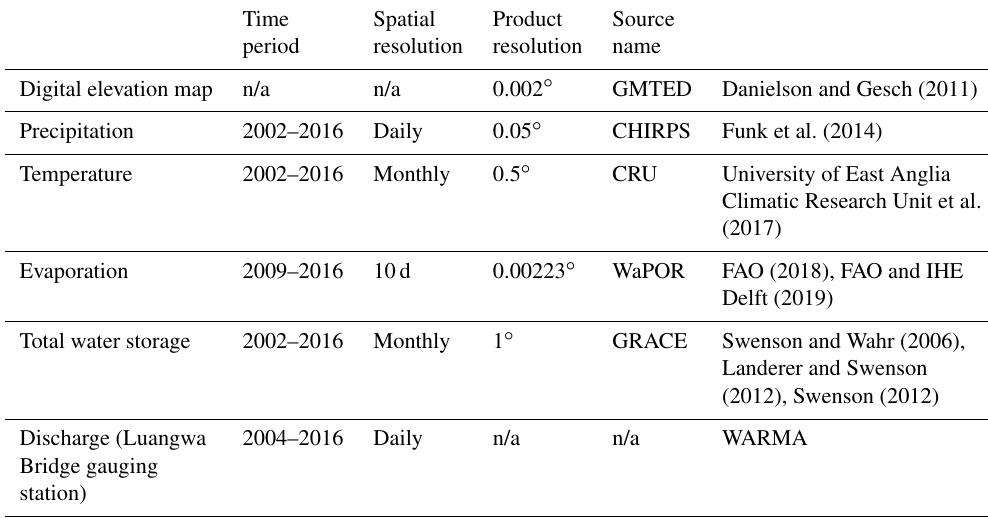
Table 1. Data used in this